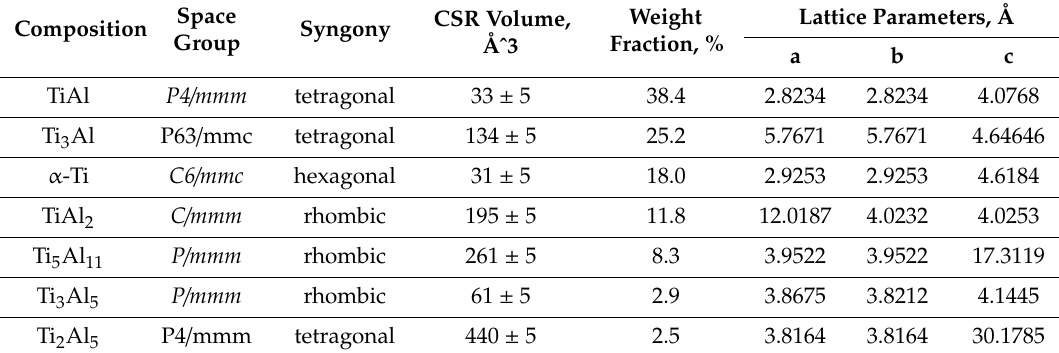
Table 7. Crystallographic data of phases in the system TA.